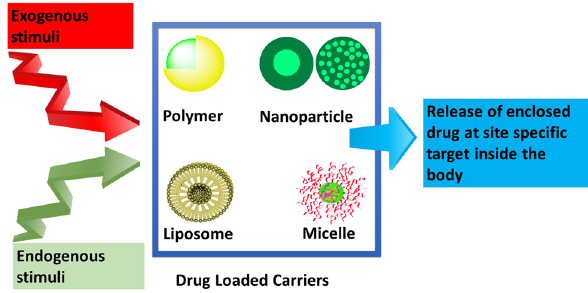
Figure 11: Stimuli responsive/triggered drug release